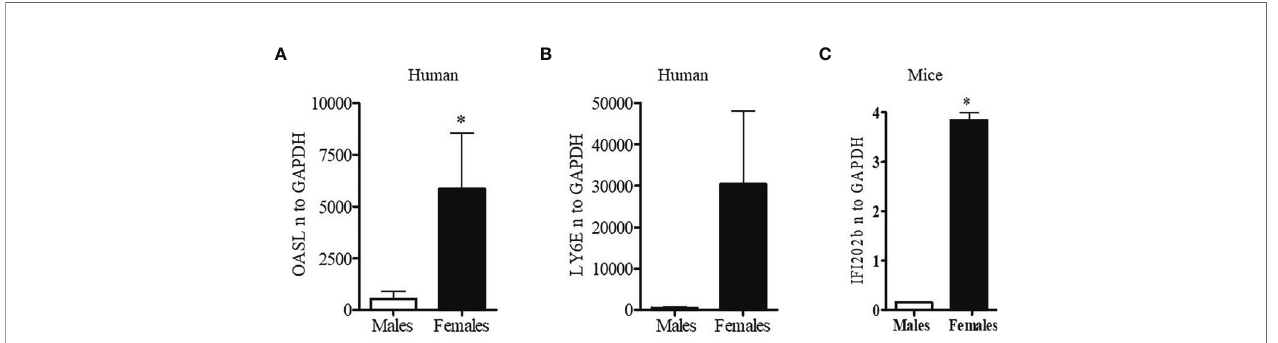
FIGURE 1 | Healthy females have signi fi cantly higher interferon-related genes. Peripheral blood mononuclear cells (PBMC) (1-2 x10 6 cells) were isolated from healthy males (n=5) and females (n=5) and RNA was isolated. 100 ng of RNA was used for real-time PCR analysis of OASL (A) and Ly6E (B) . (C) Female BWF1 mice have increased IFI202b gene expression. Splenocytes were obtained from 8-10-week-old male and female BWF1 mice (n=2), RNA isolated, and one-step real-time PCR performed with 100 ng of RNA from each sample. All values were normalized to GAPDH levels. *p